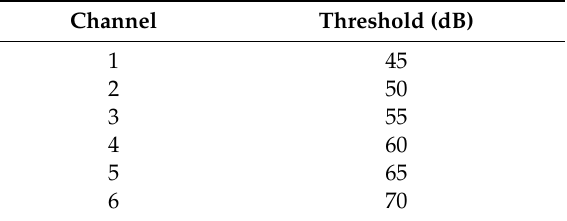
Table 2. Acquisition settings in all the channels. Figure 5. Experimental setup for evaluation of AE entropy against threshold. Figure 5. Experimental setup for evaluation of AE entropy against threshold. Table 1. Threshold for each